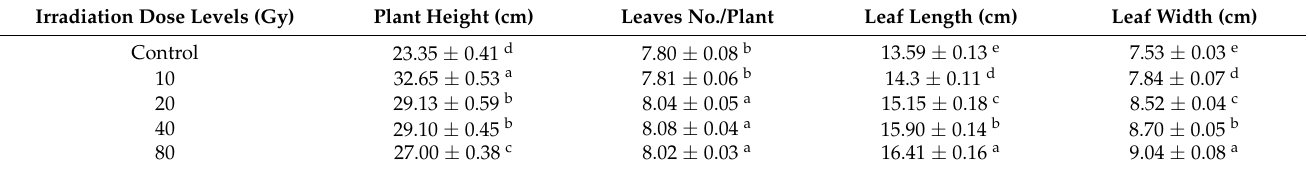
Table 2. Vegetative growth characteristics of red radish plants affected by gamma-rays at various dose levels.